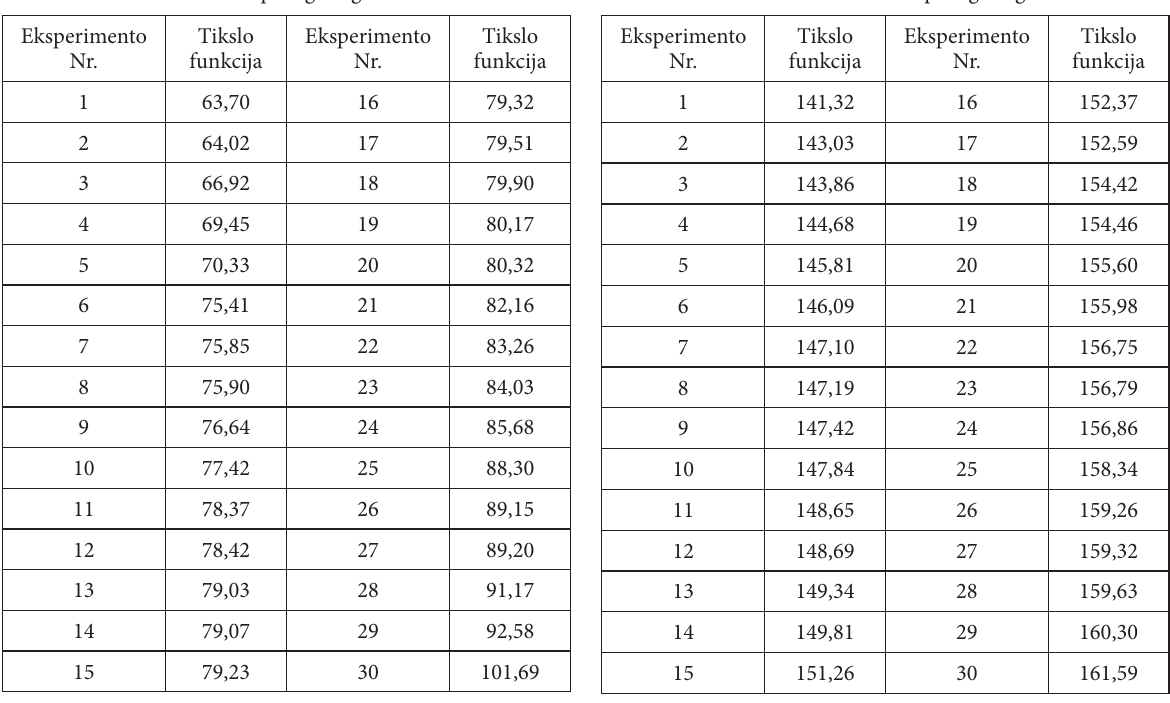
Table 3. Results for task of reactive forces–moments minimization for 10 pole